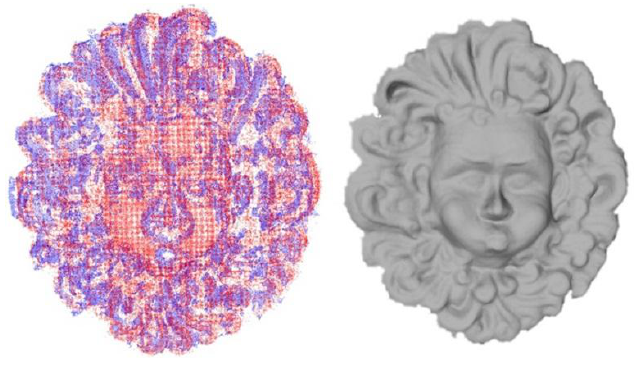
Figure14. ( Left ), comparison between the two point clouds of the Aeolus mask obtained with passive (blue points) and active technique (red points), respectively; ( Right ), triangular mesh of the Aeolus mask obtained from the integrated point